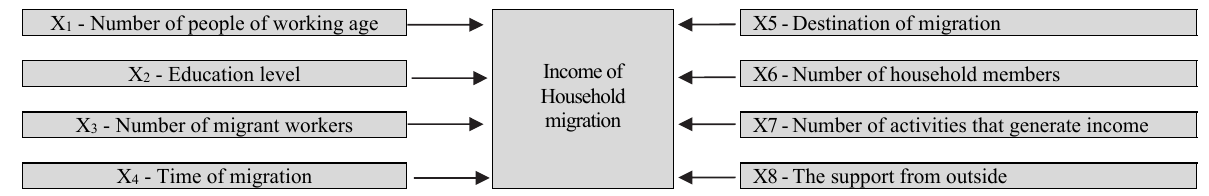
Fig.1. Research model (Source: Synthesis of the author)